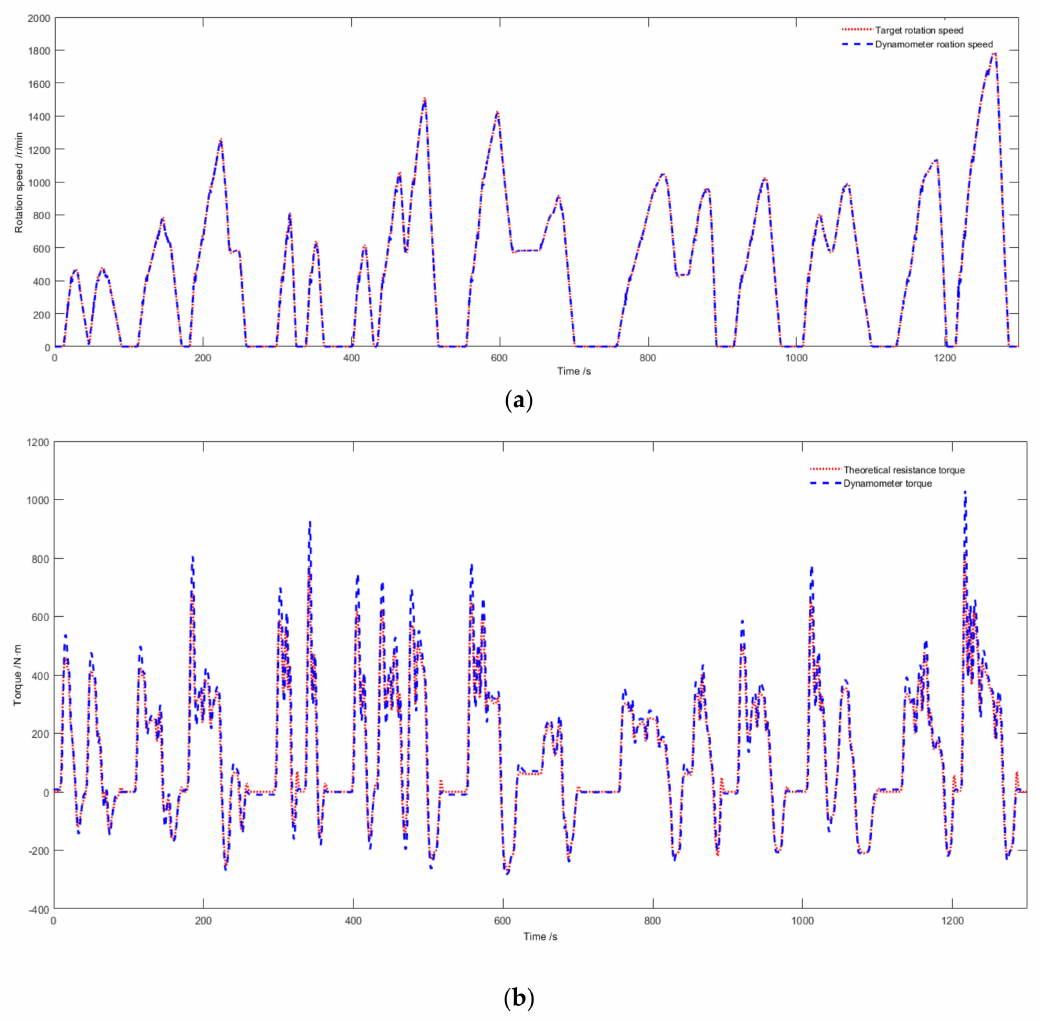
Figure 19. Curve of the powertrain: ( a ) Rotation speed and ( b )